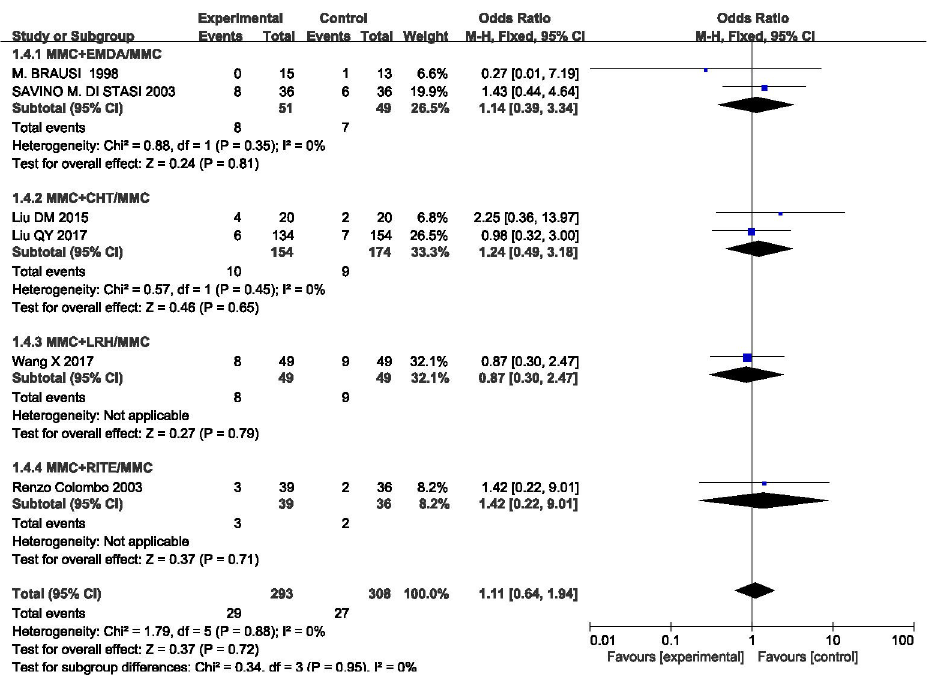
Fig 8. Forest plots for the meta-analysis of the gross haematuria by the different equipment.